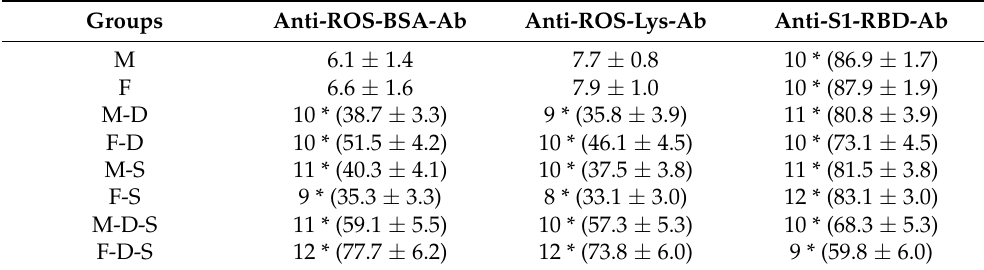
Table 2. Inhibition ELISA assay for all of the subjects from different groups against the S1-RBD antigen and various native and ROS-modified protein antigens. Groups Anti-ROS-BSA-Ab